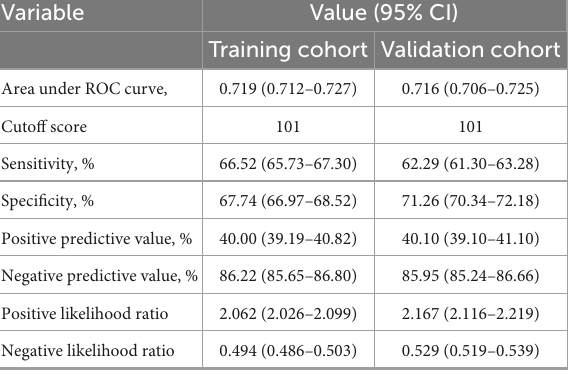
TABLE 4 Accuracy of the prediction score of the nomogram for estimating the risk of recurrent